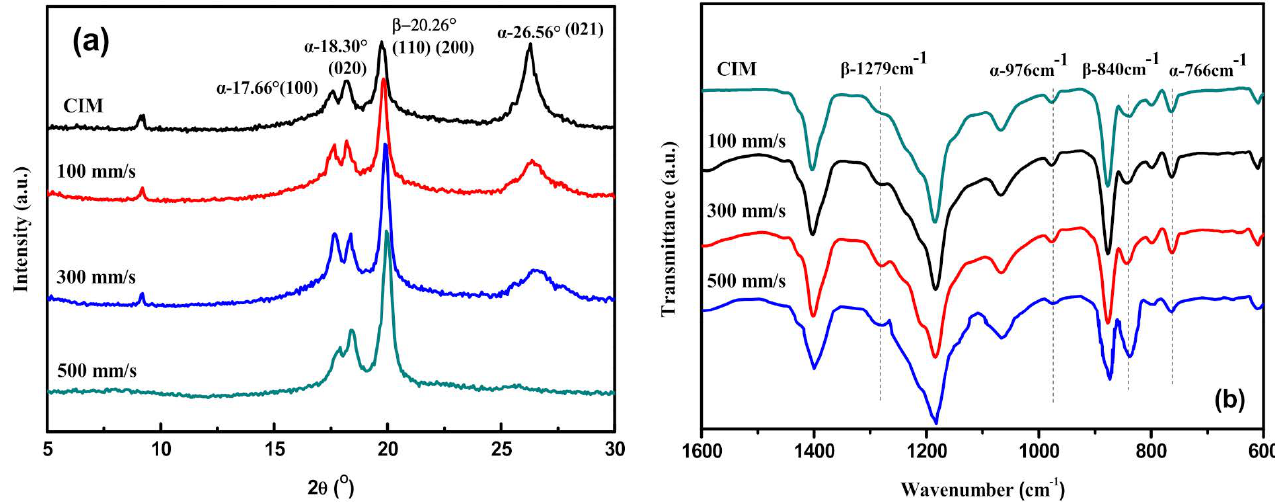
Figure 10. XRD spectra ( a ) and FTIR spectra ( b ) of PVDF/GP micro-parts at different injection speeds (Cavity temperature: 80 ◦ C; GP content: 1